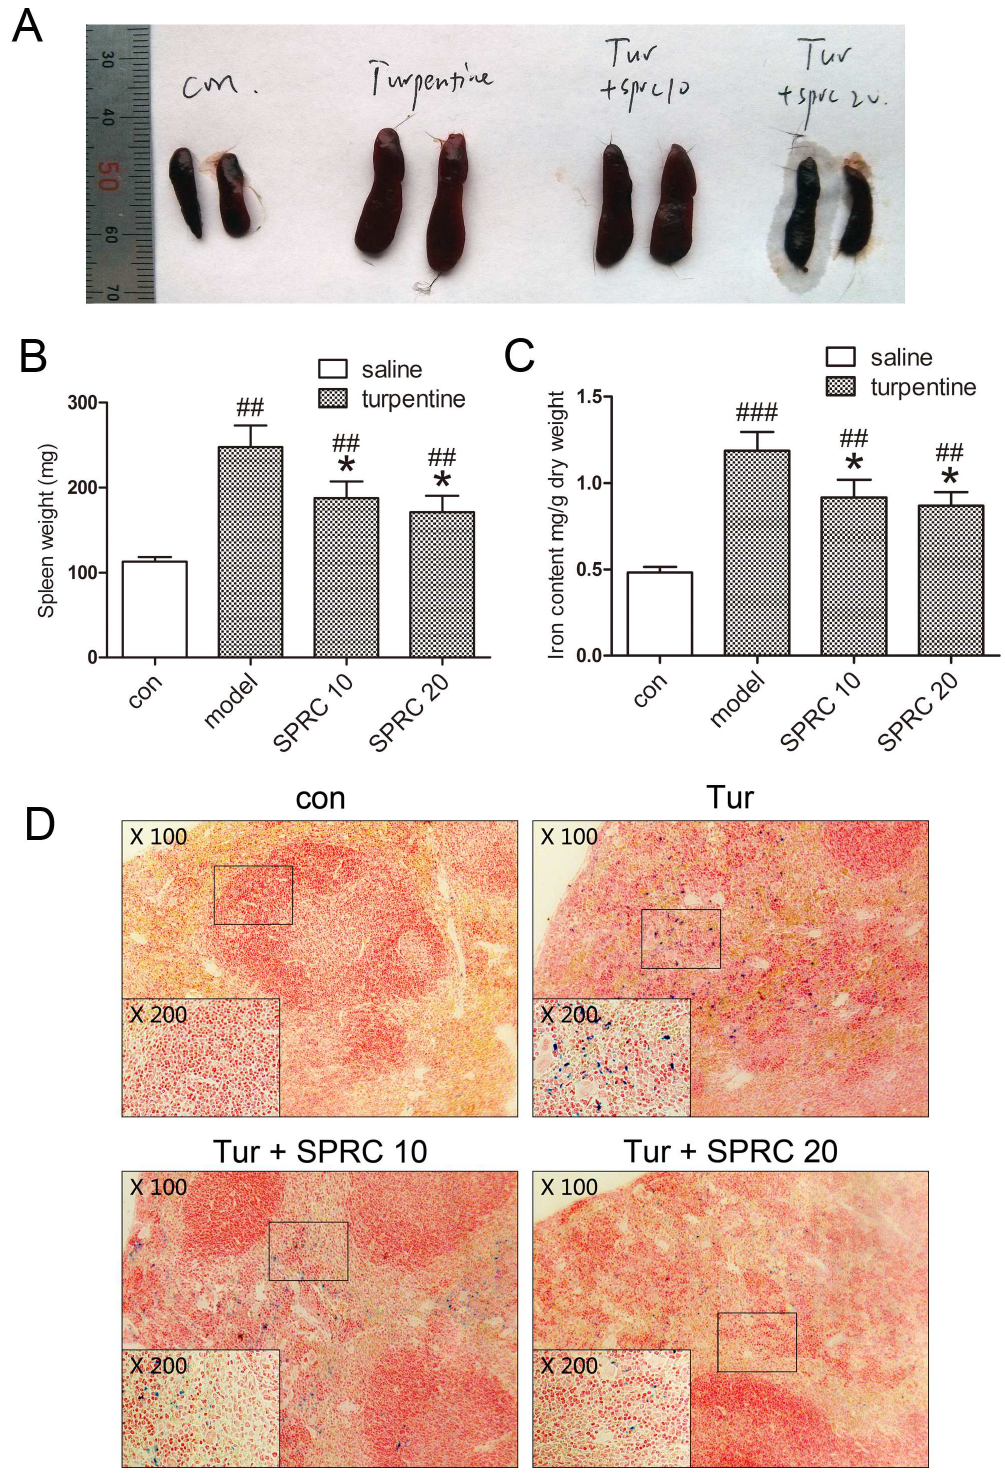
Fig 5. SPRC reduces splenomegaly and corrects splenic iron accumulation in chronic AI model. (A) Representative images indicated relieved splenomegaly by SPRC. (B) Consistentresults were observed with mouse spleenweight (n = 7). (C-D) Spleniciron accumulationwas relieved by SPRC, as assessed by non-heme iron analysis and Perl’s Prussian blue staining (n = 7). Representative images are presented. Data are presented